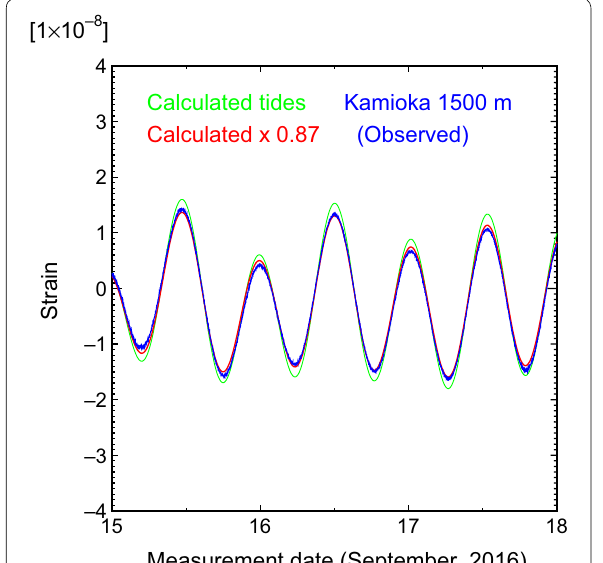
Fig. 4 Changes in the strain observed using the 1500-m laser strainmeter ( blue ). The waveform nearly agrees with the theoretical tides ( green ) but with a slightly smaller amplitude. The theoretical tides downscaled by a factor of 13% ( red ) are consistent with the topographic effects previously observed using the 100-m strainmeter located at the same Kamioka site